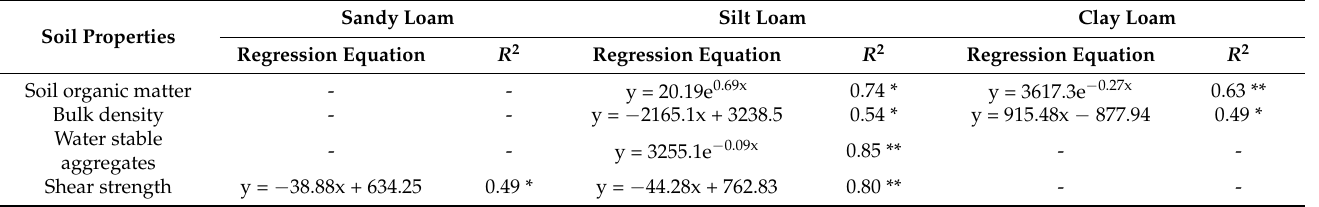
Table 2. Regression analysis of soil detachment capacities of three soils and soil properties under the condition of freeze-thaw. Soil Properties